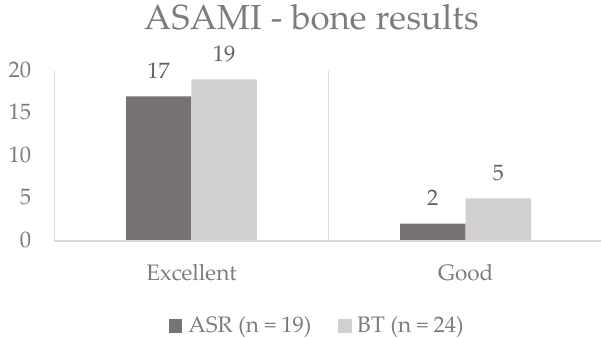
Figure 3. Results of the Association for the Advancement of Methods of Ilizarov (ASAMI) bone classification in the acute shortening/relengthening (ASR) and bone transport (BT) group. There was no statistically significant difference between the groups ( p = 0.682). The y-axis gives the absolute numbers.